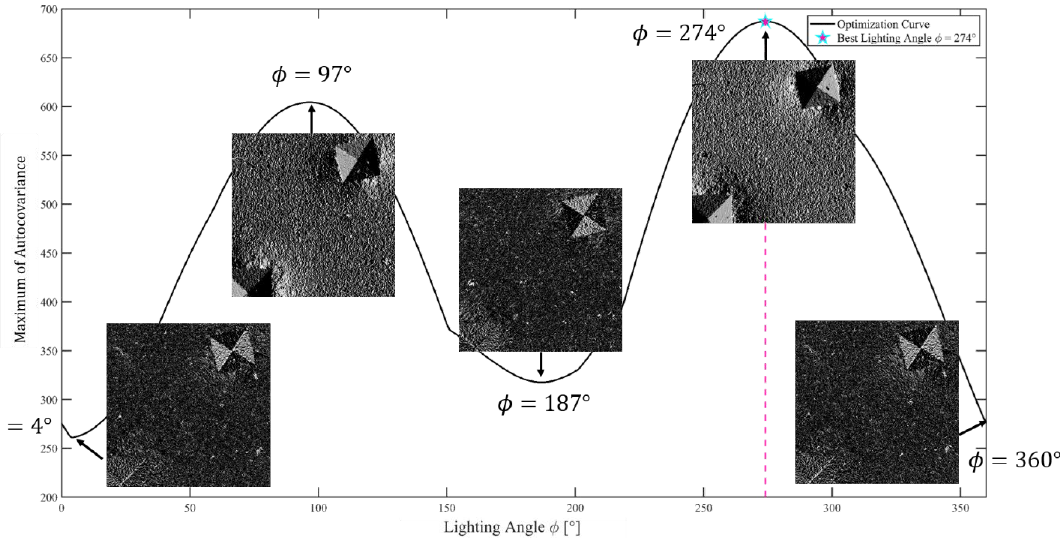
Figure 4. Optimization curve of the reflectance lighting angle φ obtained with the exhaustive enumeration reflectance algorithm for an indented surface, with the resulting reflectance maps ( θ light = 90°).